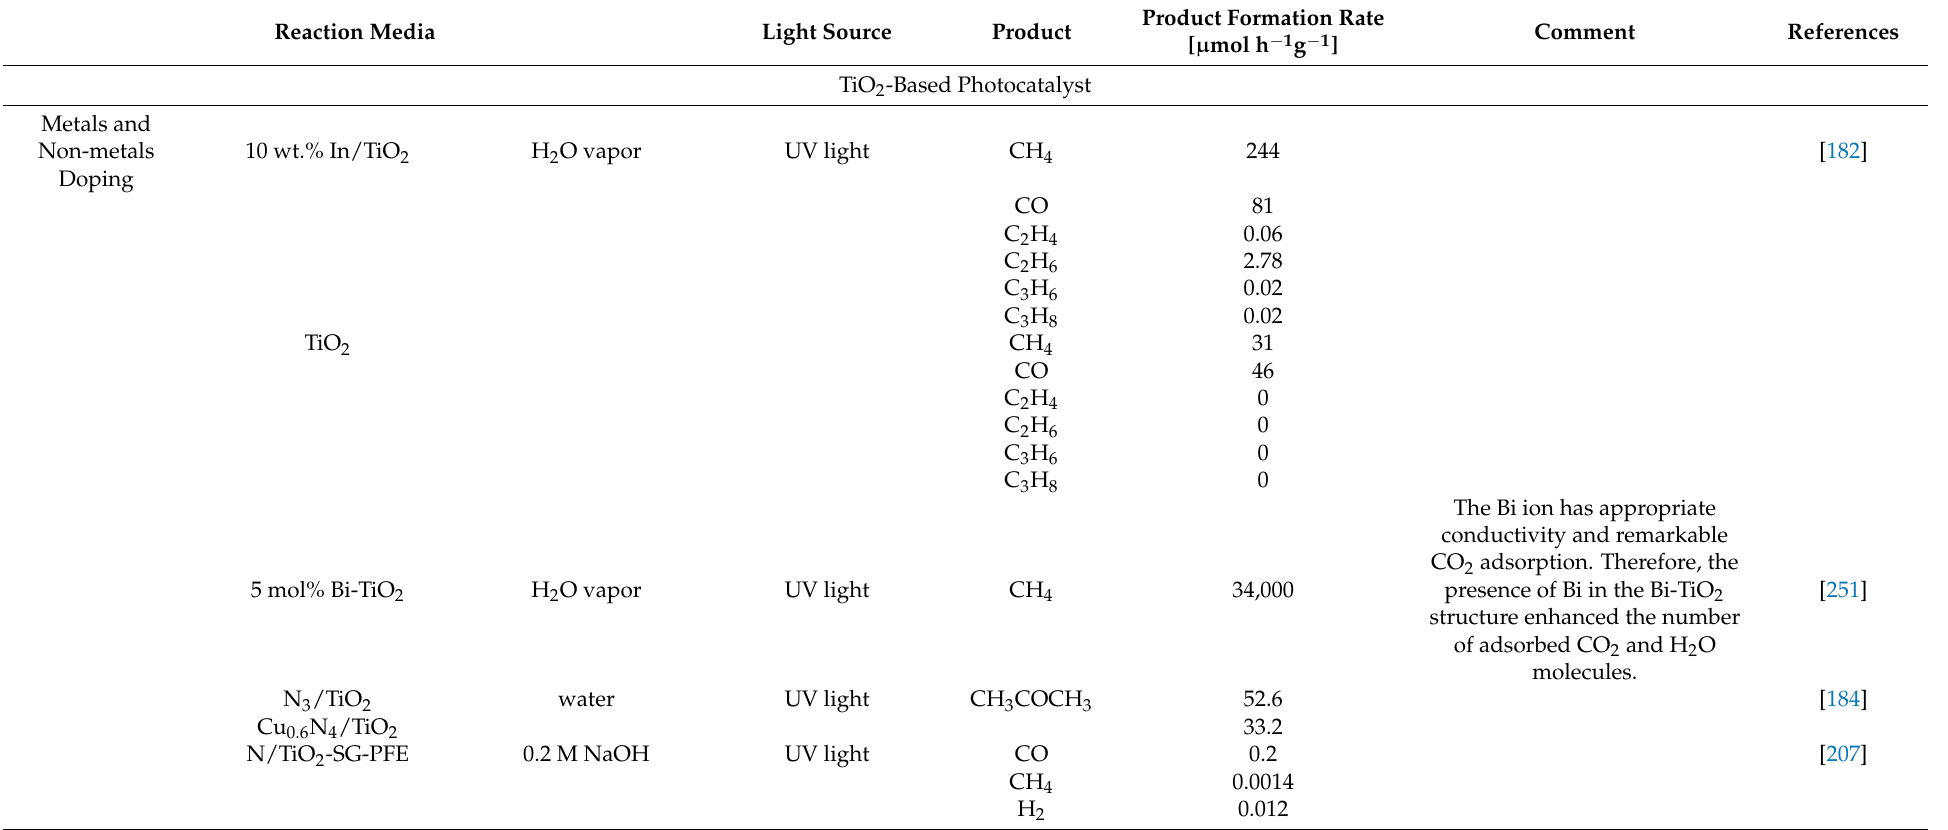
Table 5. Photocatalytic CO 2 reduction